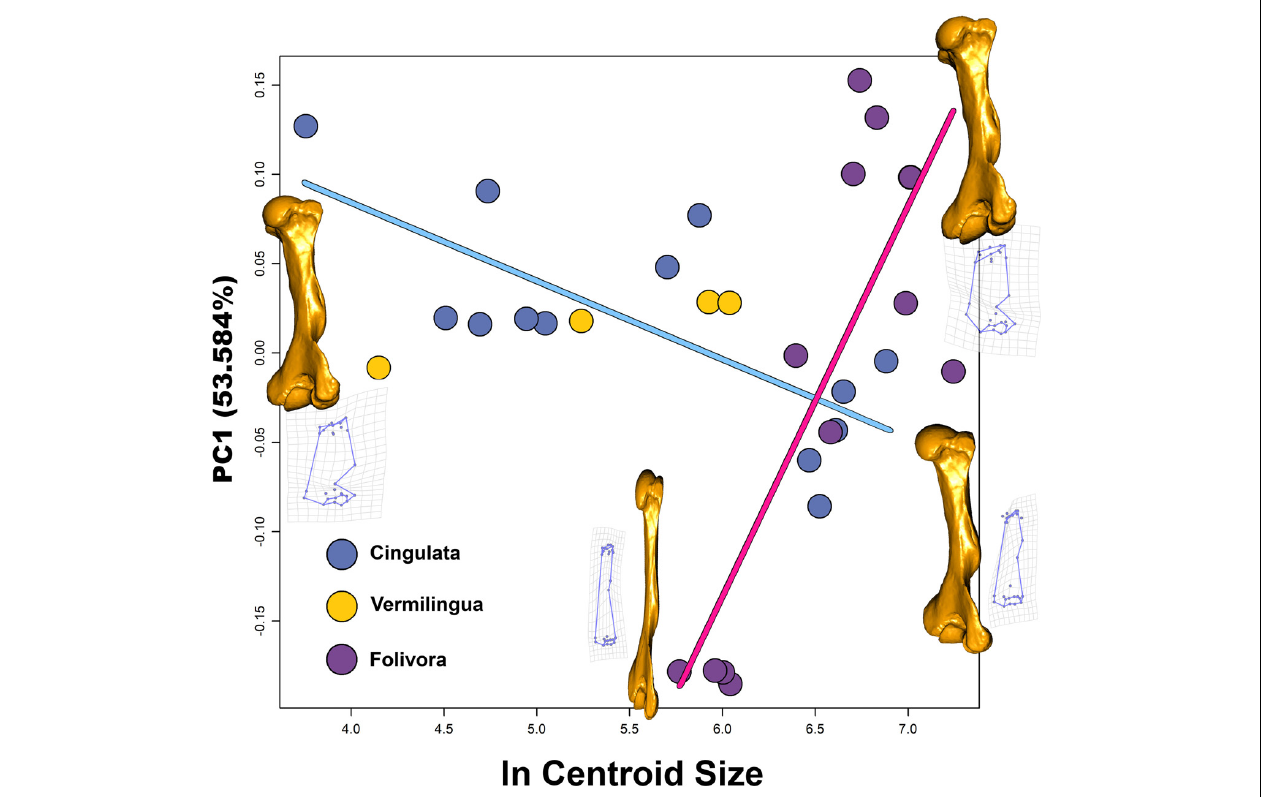
FIGURE 3 | Ln Centroid Size vs. PC1 scatter plot. Regression for Cingulata is represented by the light blue line. Regression for Folivora is represented by the pink line. At the extreme of PC1 for both groups are present the grids showing shape deformations and warping models (by using as reference T. littoralis ).